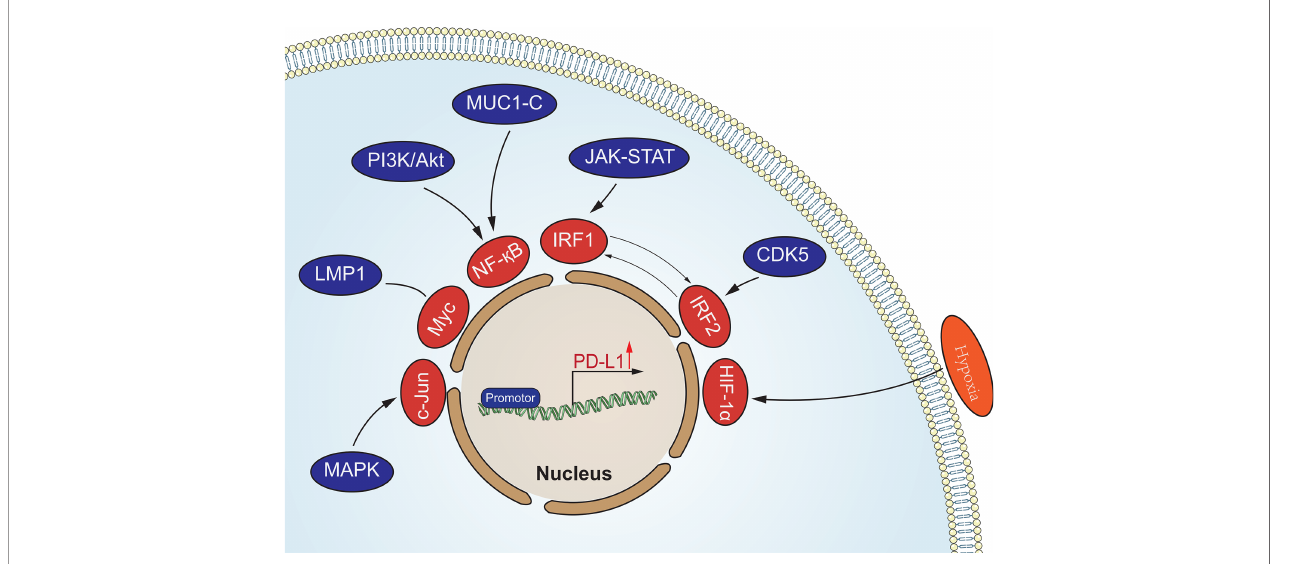
FIGURE 1 | Oncogenic signaling pathways in tumors involved in the regulation of PD-L1 expression. These signaling pathways regulate the expression of PD-L1 at the transcriptional